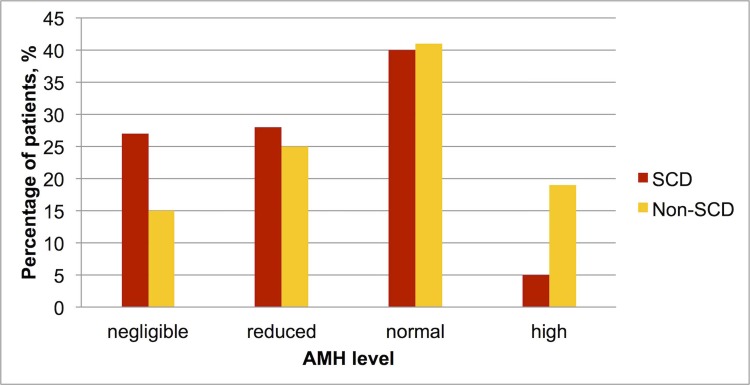
Distribution of different AMH categories in patients with and without SCD.AMH categories: negligible–less than 1.5 pmol/l; reduced -1.5 to 6.5 pmol/l; normal- 6.6 to 19.8 pmol/l; high–above 19.8 pmol/l.